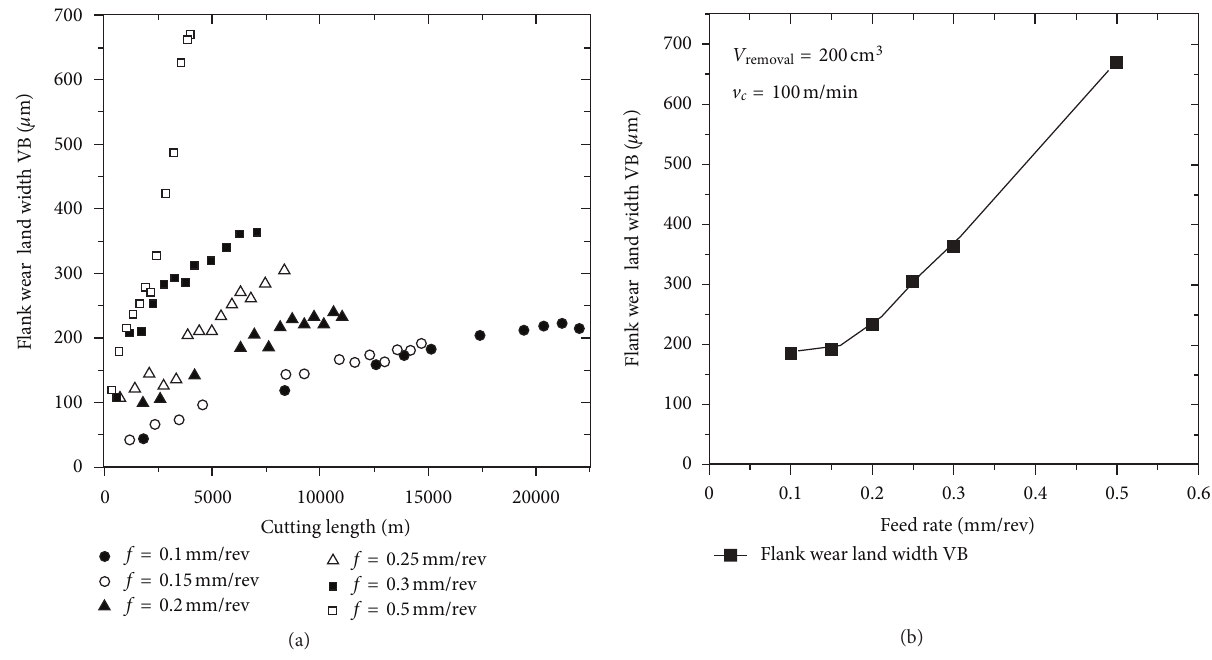
Figure 2: Flank wear land width VB measurement with respect to the cutting length for different feed rates (0.1mm/rev–0.5 mm/rev) and comparison of the final state of tool wear after material removal of 200cm 3